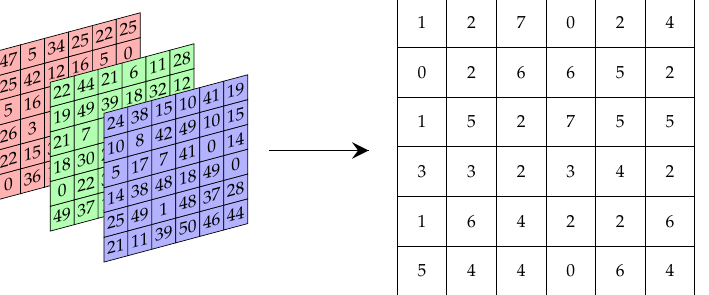
Figure 14. Compression comparison between an RGB image and its segmentation